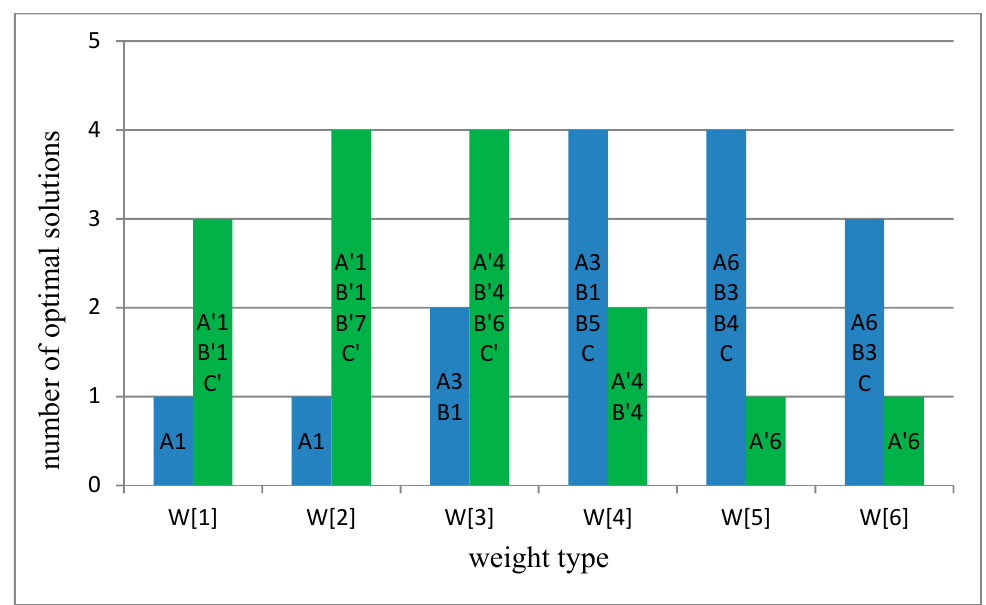
Figure 1. The number of optimal solutions for maximizing 3COWAL and minimizing 3COWAU.